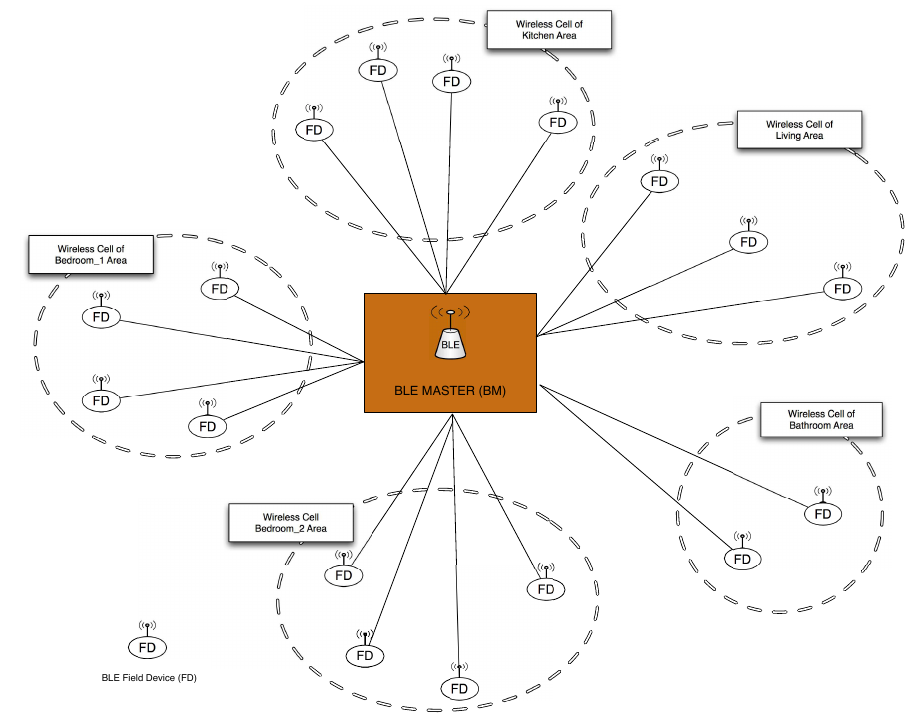
Figure 2. The proposed BLE-based wireless network